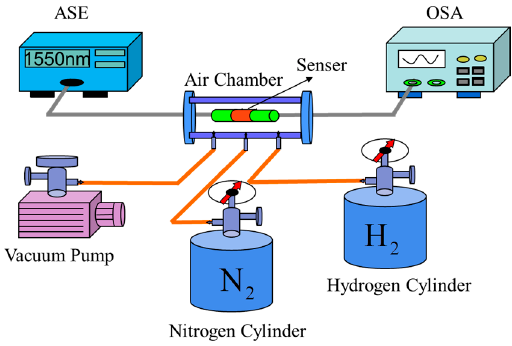
Figure 1. Schematic structure of hydrogen sensing system.